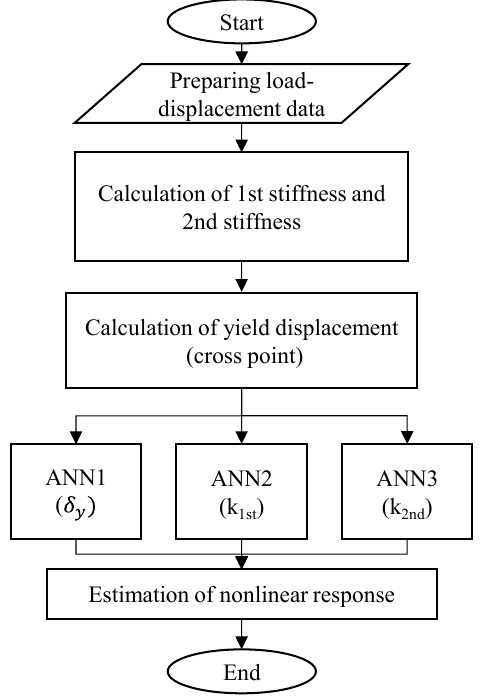
Figure 10. Flow chart for estimating the elasto-plastic response of the SCD.